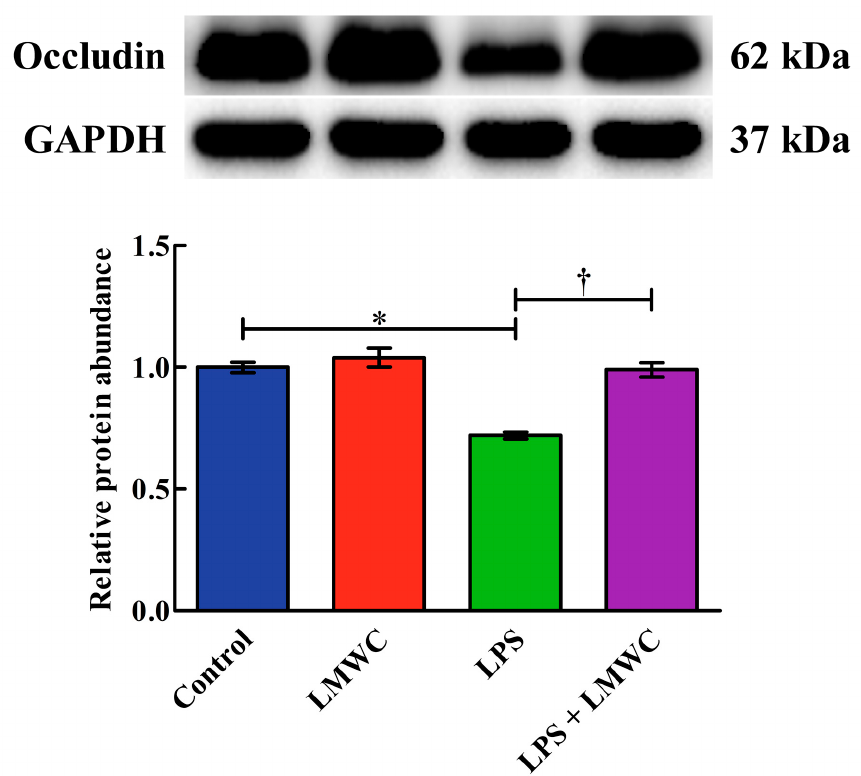
Figure 4. Effects of LMWC on the occludin abundance in LPS-treated IPEC-J2 cells. Cells were pretreated with LMWC (400 µ g/mL) for 2 h, followed by cotreatment with LPS (5 µ g/mL) for another 6 h. Data are presented as the mean ± standard error ( n = 4). * Means significant difference compared with control group ( p < 0.05). † Means significant difference compared with the LPS group ( p < 0.05).